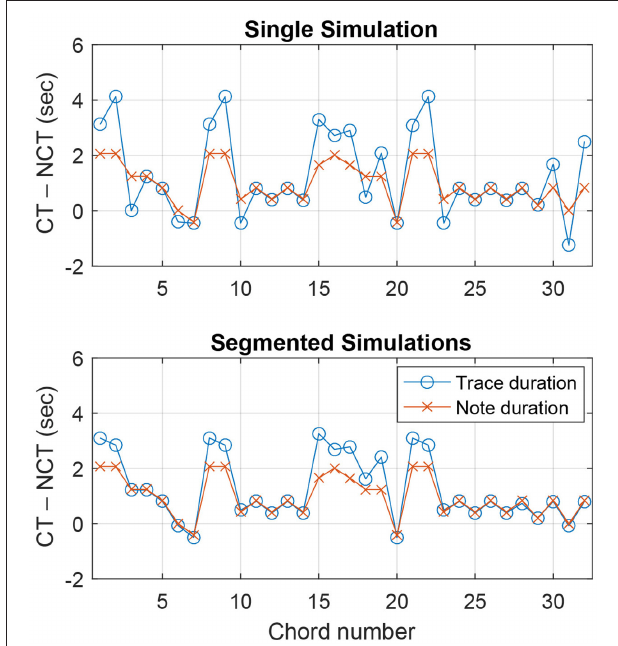
FIGURE 5 | Difference between chord pitches and nonchord pitches in total trace duration and total note duration within each chord span in Mozart Piano Sonata, K. 331, Theme. The top panel shows a single simulation run with the entire melody, and the bottom panel shows simulations for individual chord spans run separately. CT and NCT denote chord tones and nonchord tones.